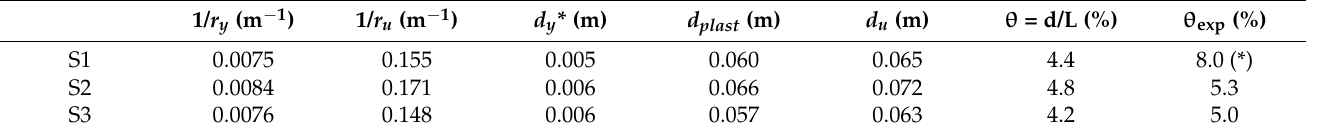
Table 5. Estimated and experimental yield and ultimate deformation capacity.